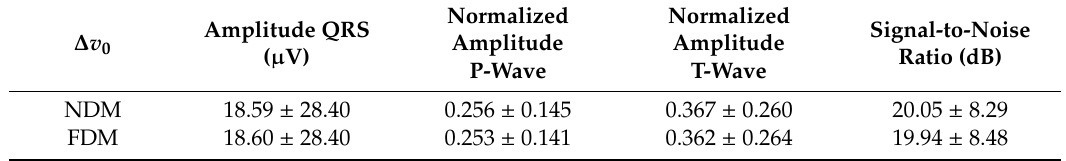
Table 3. Laplacian estimate signal metrics (mean ± standard deviation, N =